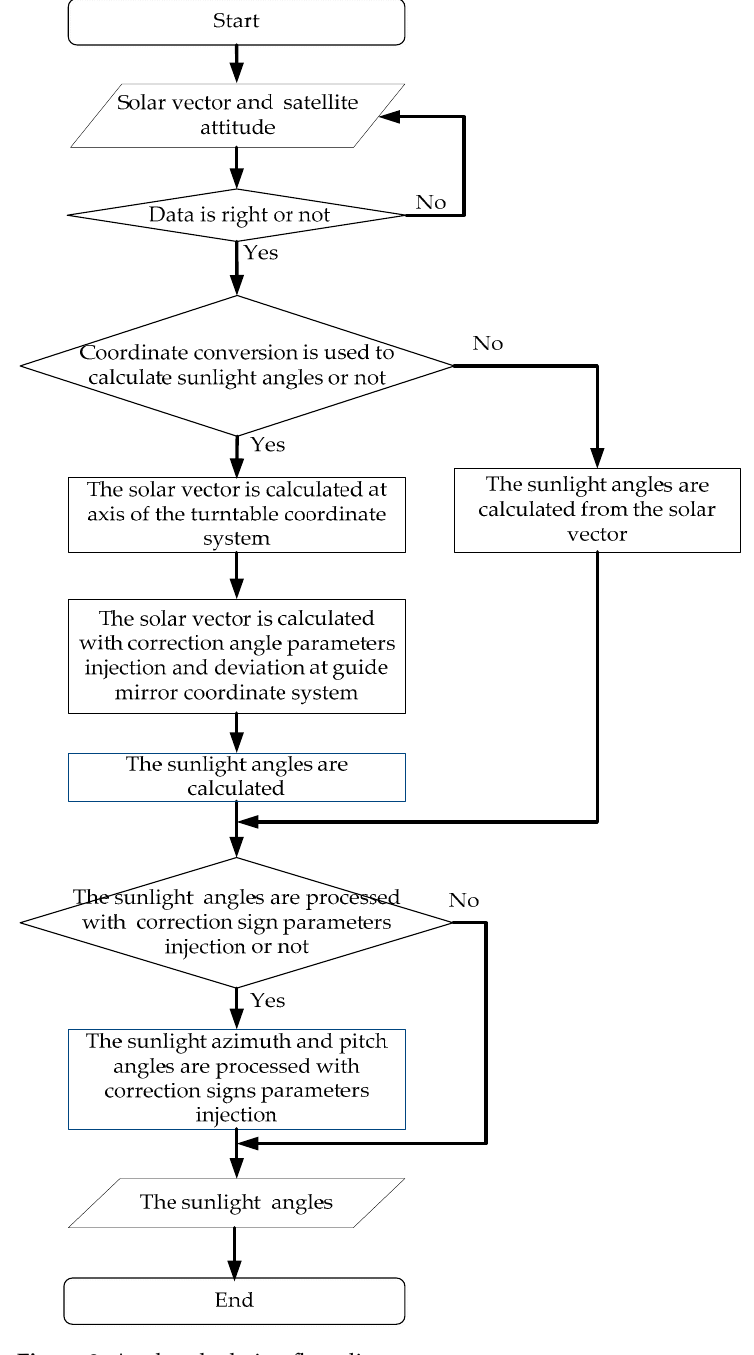
Figure 3. Angle calculation fl ow diagram.